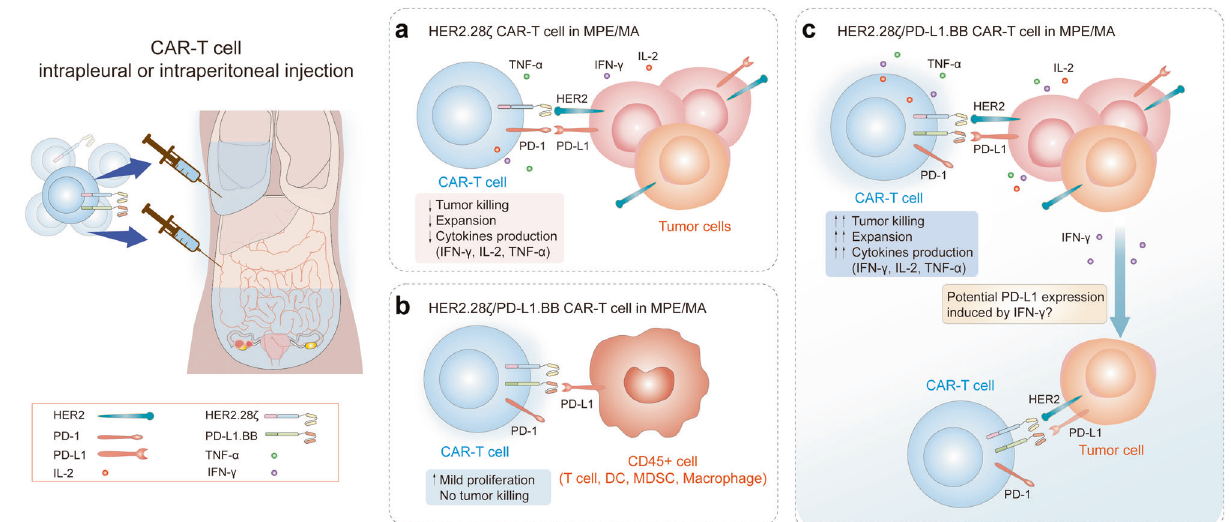
Fig. 8 A virtual treatment scenario of CAR-T cells in pleural/peritoneal cavity. a – c The therapeutic pattern and potential mechanism of regional delivery of HER2.28 ζ a and HER2.28 ζ /PD-L1.BB CAR-T cells b , c to treat pleural or peritoneal metastasis accompanied by